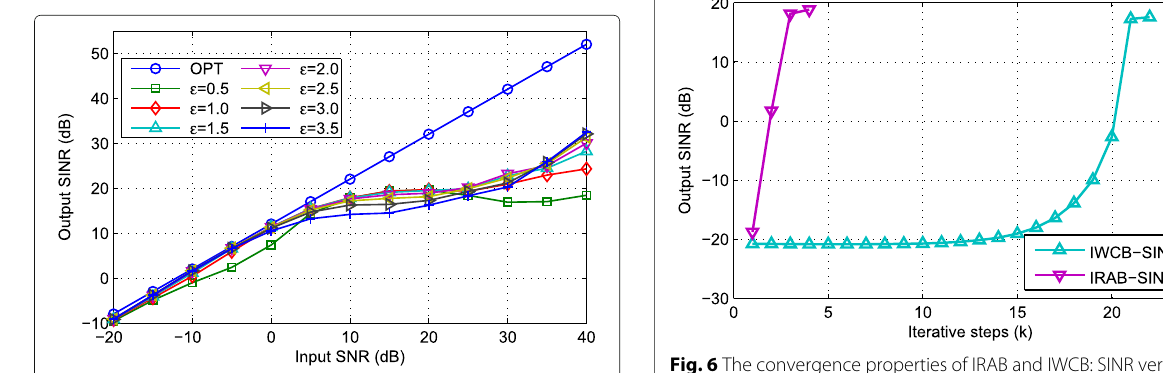
Fig. 4 SINR versus SNR with difference ε for IRAB